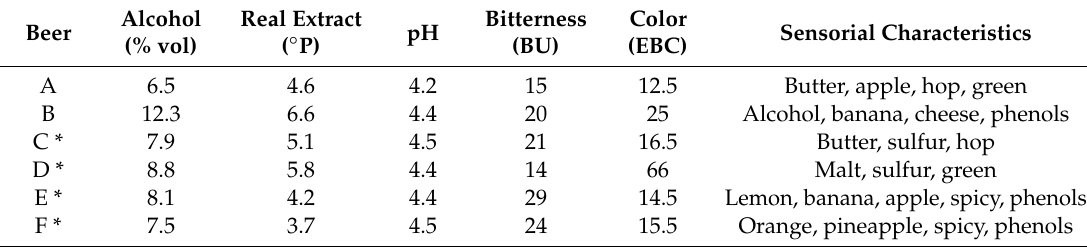
Table 1. Main characteristics of the six selected craft